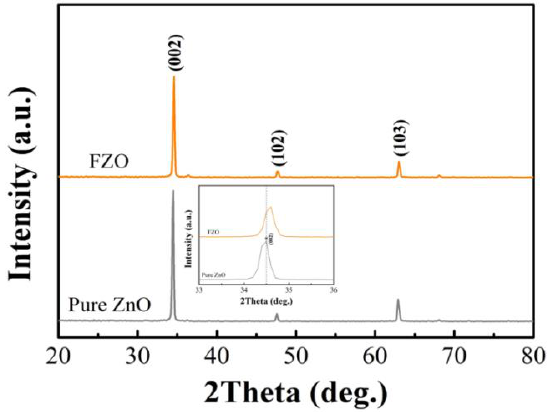
Figure 3. Comparative XRD analysis on pure ZnO and FZO NRs synthesized using the CBD method. [Figure inset shows that the (002) peak of FZO NRs has an angle shift of 0.16° toward a higher angle compared with pure ZnO NRs].